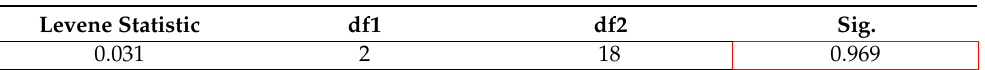
Table 5. Results of the test for equality of variance (prediction success rate of grab gestures for each subject).